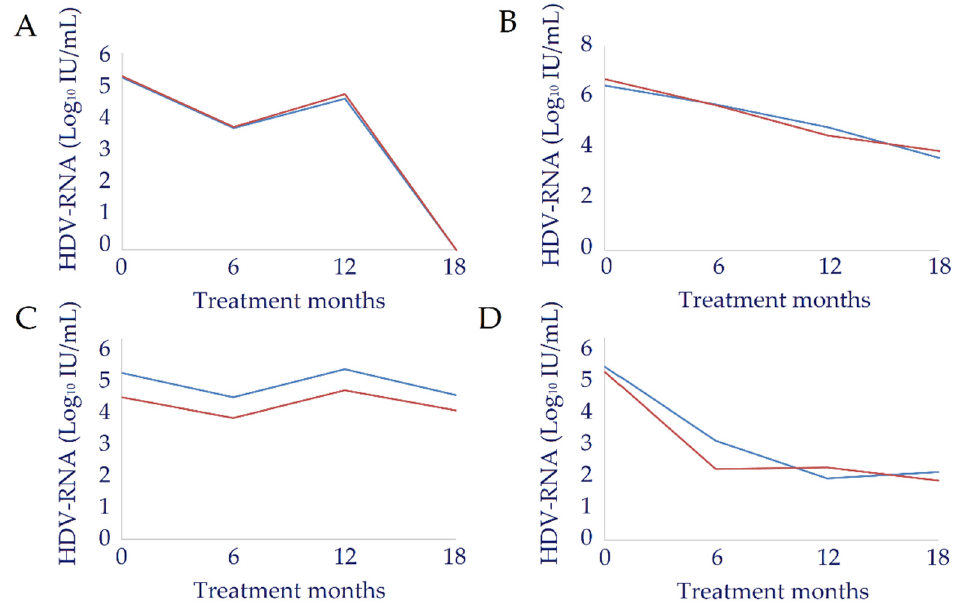
Figure 10. Comparison between kinetic patterns of HDV-RNA viral load measured by RT-qPCR (blue line) and ddPCR (red line) in longitudinal plasma samples from four patients (from A to D ) treated with PEG-IFN α . HDV-RNA was evaluated at baseline and at months 6, 12 and 18 during treatment.